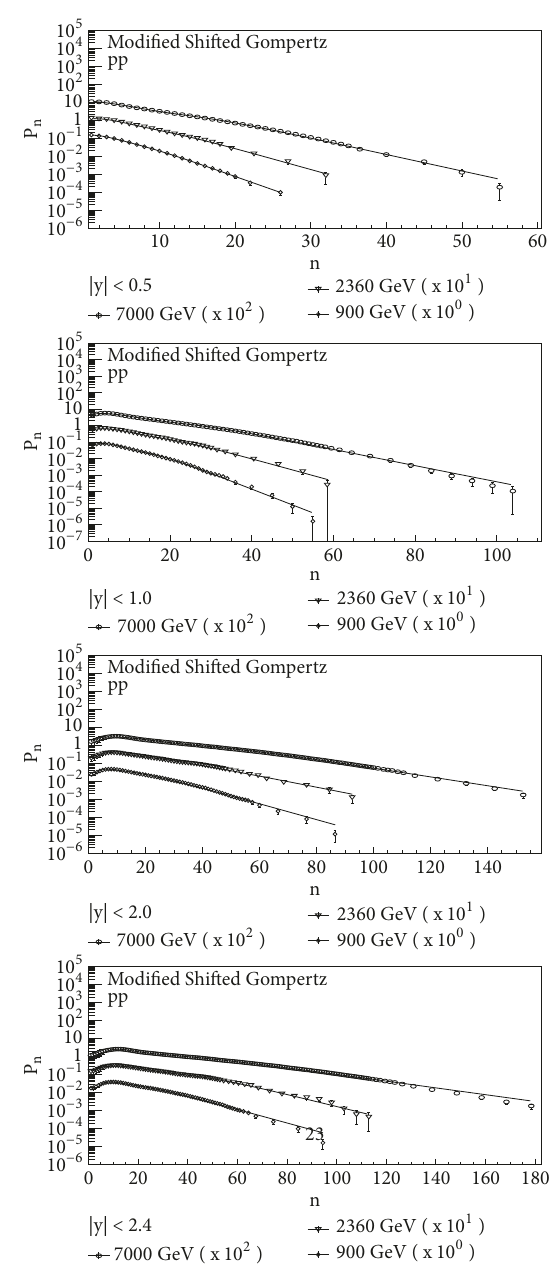
Figure 7: Charged multiplicity distributions in 𝑝𝑝 collisions in four rapidity windows for the modified shifted Gompertz distributions.